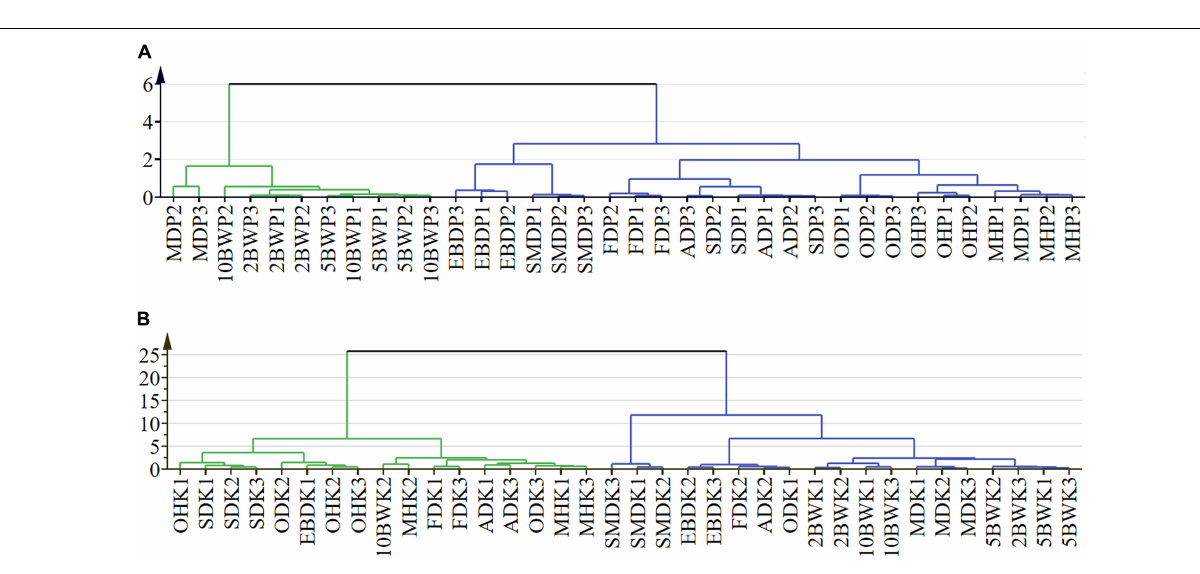
Frontiers in Plant Science |